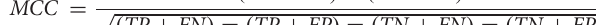
Frontiers in Cell and Developmental Biology |